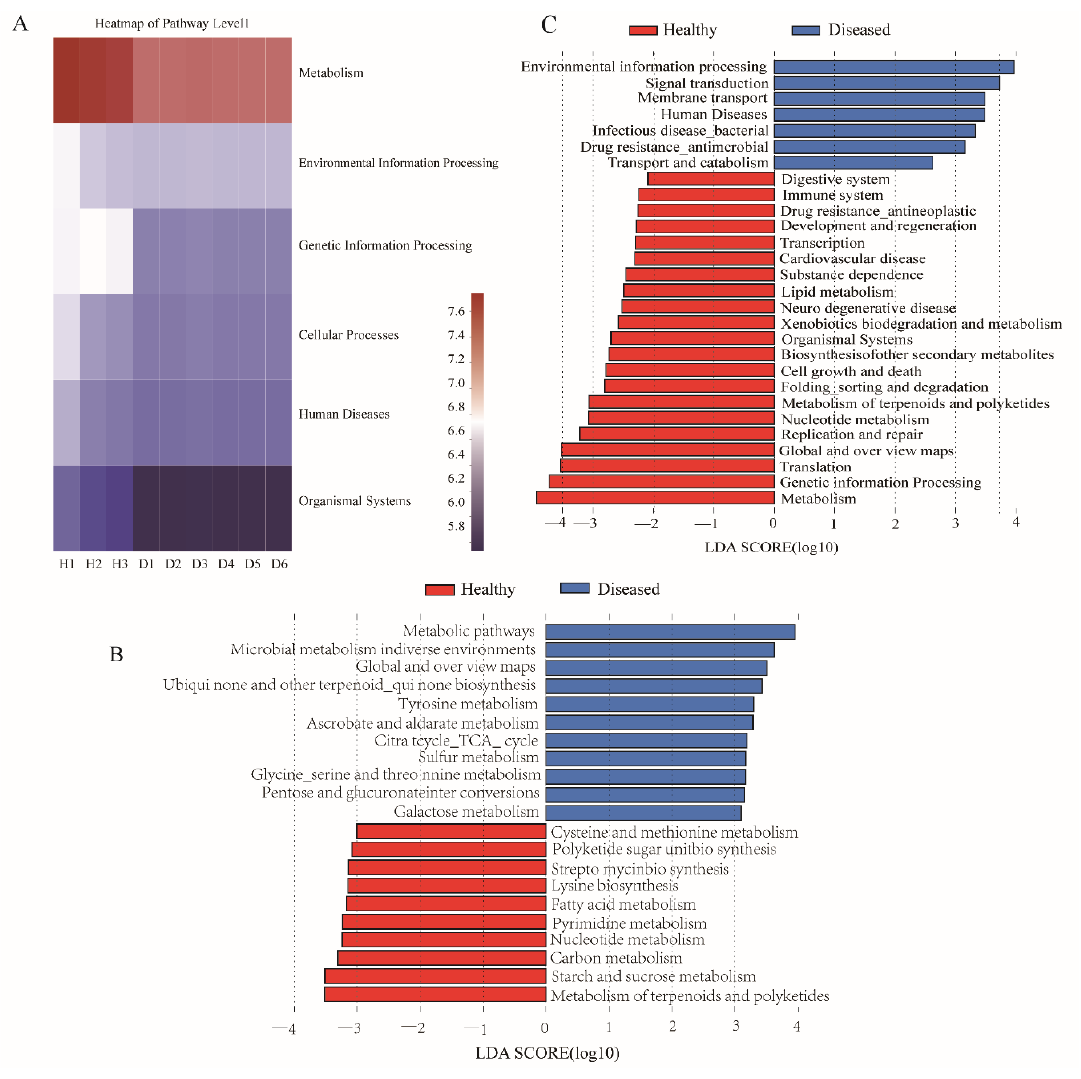
Figure 5. Differences in the predicted functions of the intestinal microbiota between the healthy and diseased groups. ( A ) Heatmap showing the main of pathway level 1. ( B ) LEfSe determined differences in metabolism of the intestinal microbiota between the healthy and diseased groups. ( C ) LEfSe determined differences in pathway level 2 of the intestinal microbiota between the healthy and diseased groups.